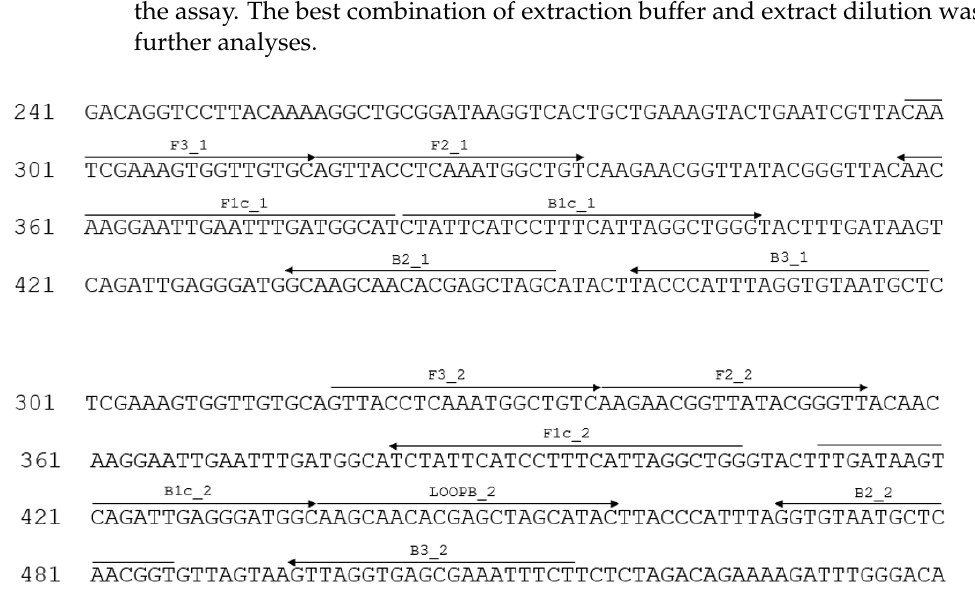
Table 2. Degenerate real-time PCR primers for detection of SBCMV and primers for amplification of the complete coat protein